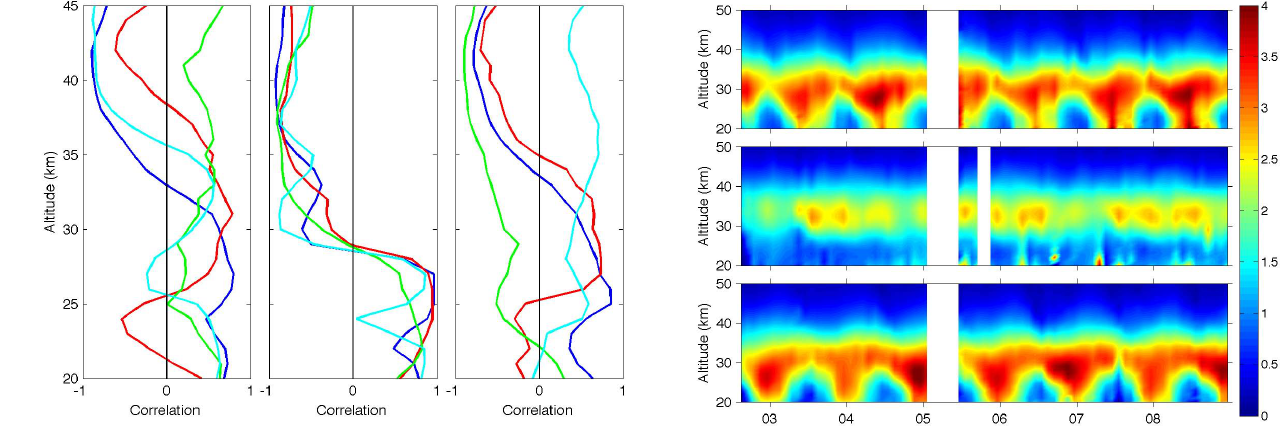
Fig. 16. Monthly NO 2 number density in the stratosphere in three latitude belts in 2002–2008 as a function of time and altitude. The density is scaled by 10 9 cm − 3 . The time covered is 1 August 2002– 31 December 2008. Latitude belts: 30 ◦ N–50 ◦ N (top), 10 ◦ S– 10 ◦ N (middle), 30 ◦ S–50 ◦ S